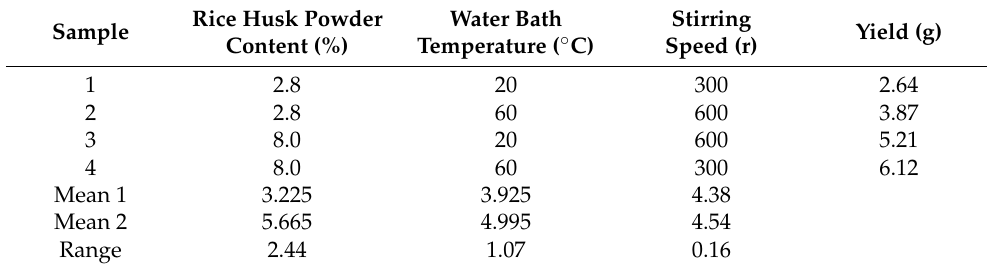
Table 6. Results of output of microcapsules.